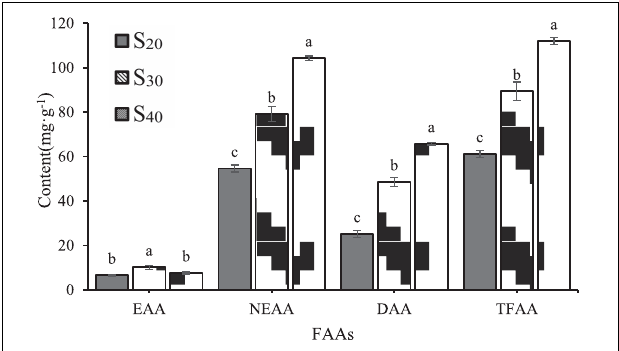
FIGURE 6 | Concentrations of EAAs, NEAAs and DAAs in the gill tissue of Sinonovacula constricta under different salinities. EAAs, essential amino acids; NEAAs, non-essential amino acids; DAAs, delicious amino acids. The different letters mean significant difference ( P <